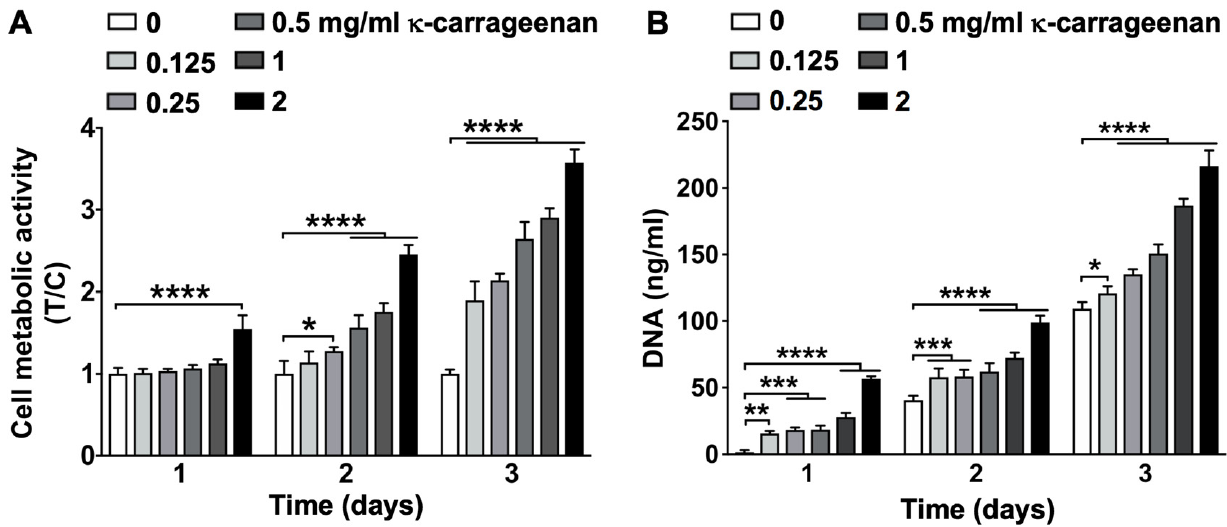
Figure 5. K-carrageenan enhanced MC3T3-E1 pre-osteoblast metabolic activity and proliferation from day 1 to day 3. ( A ) Presto-blue cell metabolic activity. Data are expressed as κ -carrageenan-treated-over-control (T/C) ratio. ( B ) Total cellular DNA content. Values are mean ± SD from 4 independent experiments. Significant effect of κ -carrageenan, * p < 0.05, ** p < 0.01, *** p < 0.001, **** p < 0.0001.